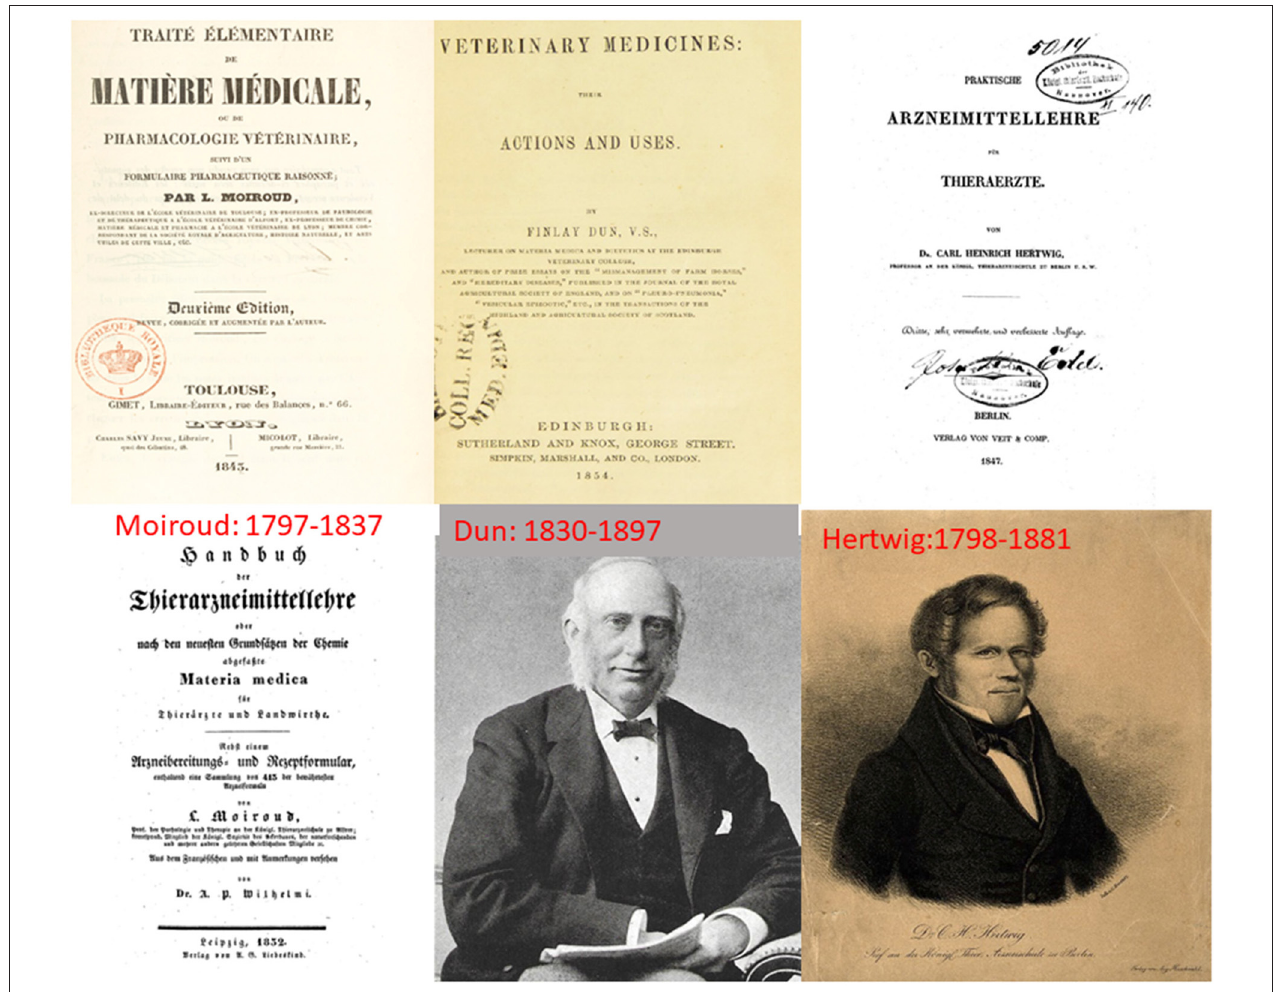
FIGURE 4 | The first three major textbooks of veterinary Materia Medica were published in French, German and English in the mid-nineteenth century. Louis Moiroud (no known picture) was born in 1797. He studied veterinary medicine in Lyon. He became a professor in Lyon in 1824, was appointed to Alfort in 1829 and finally became the Dean of the new veterinary school in Toulouse in 1832. Moiroud published relatively little (he died aged 40) but his book entitled “ Traité élémentaire de matière médicale ou de pharmacologie vétérinaire ” (first edition in 1831) became a standard text in France. This book was immediately translated into German in 1832 (Handbuch der Thierarzneimittellehre, oder nach den neuesten Grundsätzen der Chemie abgefaßte Materia medica für Thierärzte Und Landwirthe. Nebst einem Arzneibereitungs-u. Rezeptformular enthaltend eine Sammlung von 413 Rezepten der bewährtesten Arzneiformeln). Finlay Dun, in the preface to the first edition of his ‘Veterinary Medicine’ in 1853 indicated that the Moiroud book was consulted as well as Hertwig’s “Handbuch der Praktische Arzneimittellehre für Thieraerzte.” Carl Heinrich Hertwig was born in 1798. He studied both medicine and veterinary medicine. Hertwig was appointed as a repetitor at the Berliner Tierarzneischule and became head of the clinic for small animals. He had a reputation as a highly skilled surgeon and was appointed as professor in 1833, teaching several subjects including practical pharmacology. Together with Ernst Friedrich Gurlt, he founded the “Magazin für die gesammte Thierheilkunde,” (Magazine for the entirety